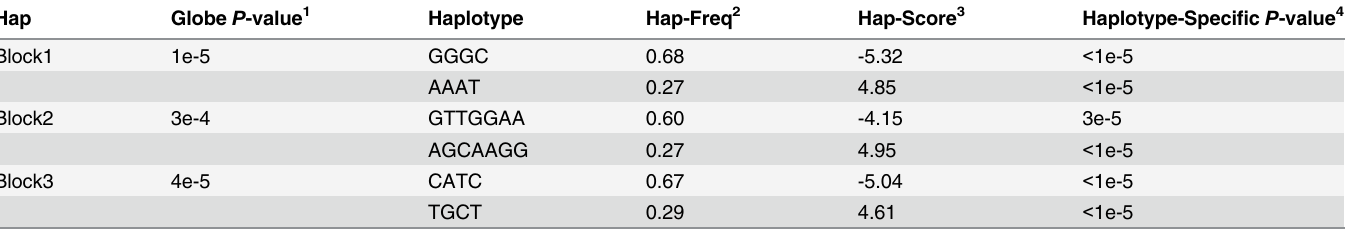
Table 5. Results of haplotype association analysis for linkage disequilibrium blocks showing association with egg number from 21 to 26 weeks on